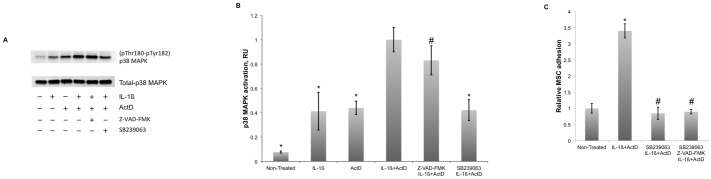
P38 MAPK phosphorylation in HUVECs and its role in the regulation of the MSC adhesion.P38 MAPK kinase activation was studied in HUVECs treated for 4 hours at 37°C and 5% CO2 in supplemented EGM-2 medium with 10 ng/ml IL-1ß, 10 µg/ml actinomycin D (ActD) or a mixture of 10 ng/ml IL-1ß and 10 µg/ml actinomycin D (ActD) in the absence and presence of 50 µM Z-VAD-FMK or 50 µM SB239063. Panel A shows the Western Blot analysis of p38 MAPK phosphorylation at Thr-180 and Tyr-182 in untreated HUVECs and HUVECs treated with IL-1ß, actinomycin D or a mixture of IL-1ß and actinomycin D in the presence and absence of Z-VAD-FMK or SB239063. Staining for total p38 MAPK was performed to normalize the signals from phosphorylated p38 MAPK. Panel B shows quantitative analysis of p38 MAPK activation. Western blot images were acquired on a Kodak Image Station 440 and processed with supplemented software. P38 MAPK phosphorylation in untreated HUVECs and HUVECs treated with IL-1ß or actinomycin D was 8%, 40% and 44%, respectively, relative to the level of p38 MAPK phosphorylation in HUVECs treated with a mixture of IL-1ß and actinomycin D. Z-VAD-FMK did not affect p38 MAPK activation in HUVECs treated with IL-1ß in the presence of actinomycin D. The level of p38 MAPK phosphorylation in the presence of SB239063 was 42% of that found in HUVECs treated with IL-1ß in the presence of actinomycin D. Data shown are the averages and standard deviations of three Western Blot analyses. Pound key marks statistically insignificant effect of Z-VAD-FMK on p38 MAPK phosphorylation (p-value >0.05). Asterisks mark statistically significant differences (p-value <0.05) in p38 MAPK phosphorylation in comparison with p38 MAPK phosphorylation in HUVECs treated with IL-1ß in the presence of actinomycin D. Panel C shows the effect of SB239063 on MSC adhesion to HUVECs. HUVECs were treated with a mixture of 10 ng/ml IL-1ß and 10 µg/ml actinomycin D (ActD) in the presence and absence of 50 µM SB239063. In the presence of SB239063 MSC adhesion was indistinguishable from the adhesion to untreated HUVECs (marked with a pound key, p-value >0.05). Combination of SB239063 and 50 µM Z-VAD-FMK had no further effect on the MSC adhesion and was not significantly different from MSC adhesion to untreated HUVECs (marked with a pound key, p-value >0.05). Data shown are the averages and standard deviations of five adhesion assays. Asterisk marks statistically significant 3.4-fold increase (p-value <0.05) in the MSC adhesion in comparison with the adhesion to untreated HUVECs.